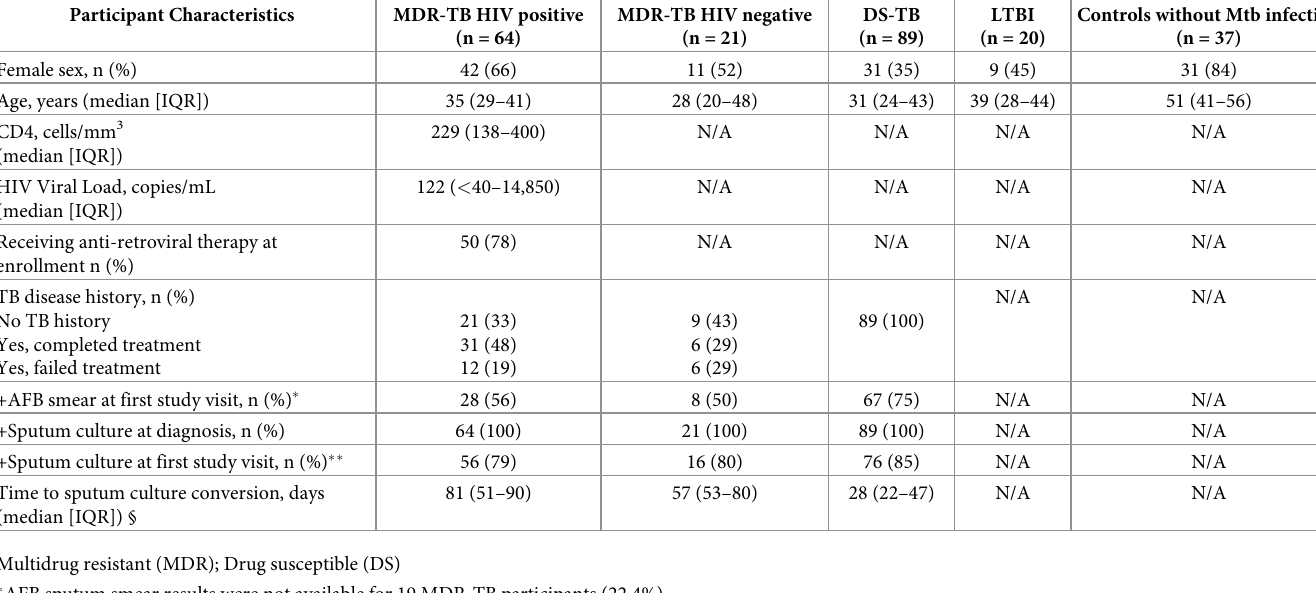
Table 1. Clinical and demographic characteristics of study